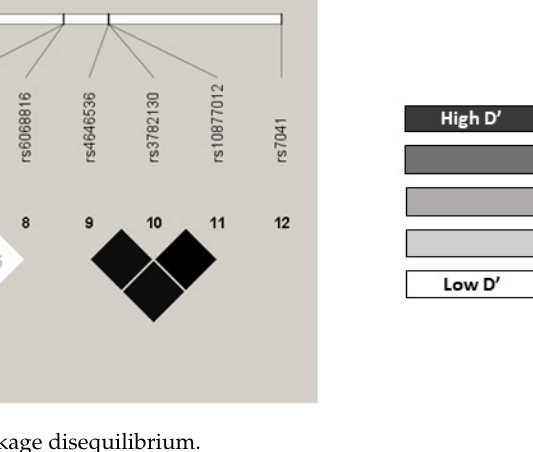
Figure 1. Linkage disequilibrium.